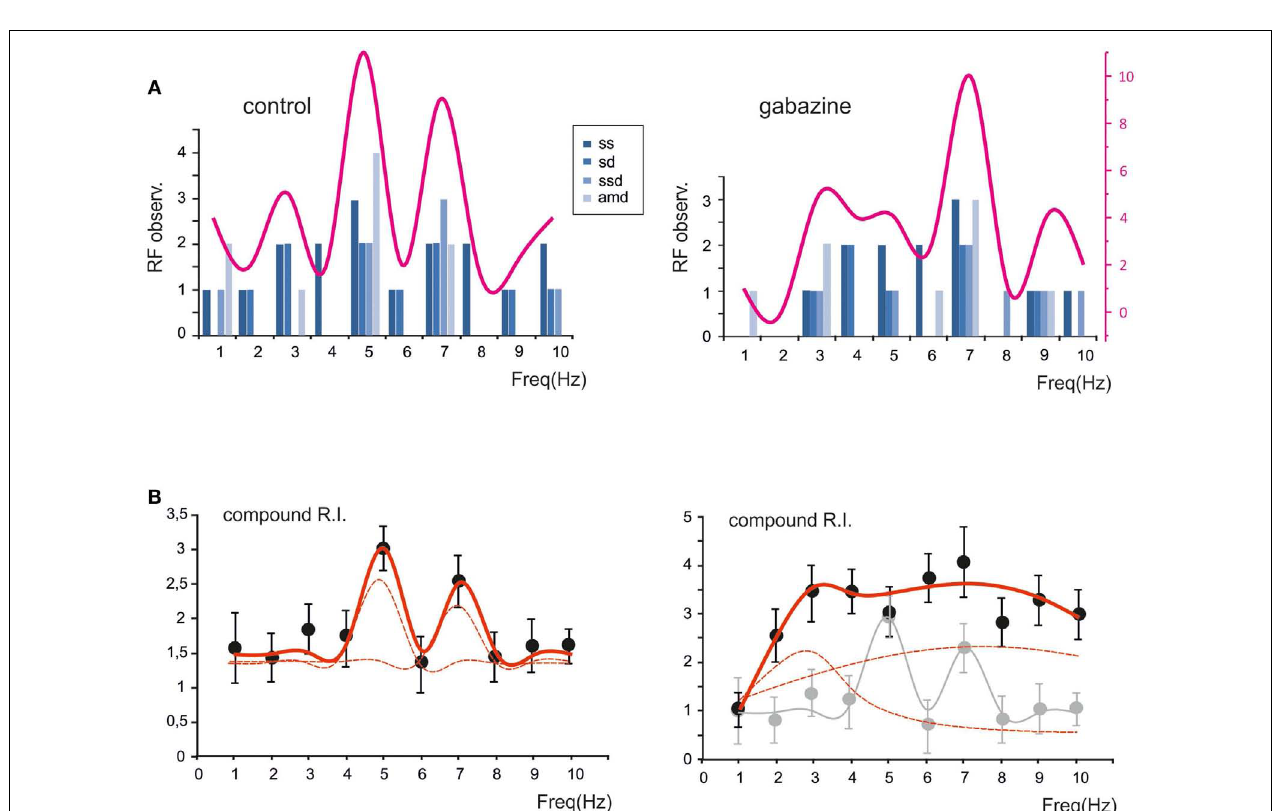
shows the compound resonance index (RI) calculated from all the neurons recorded in control and in the presence of gabazine. Note peaks at 5–7Hz. Data are reported as mean ± SEM. Red lines fitting the data point represent double Lorentzian functions (broken lines are the two individual component functions) obtained on control and gabazine data,